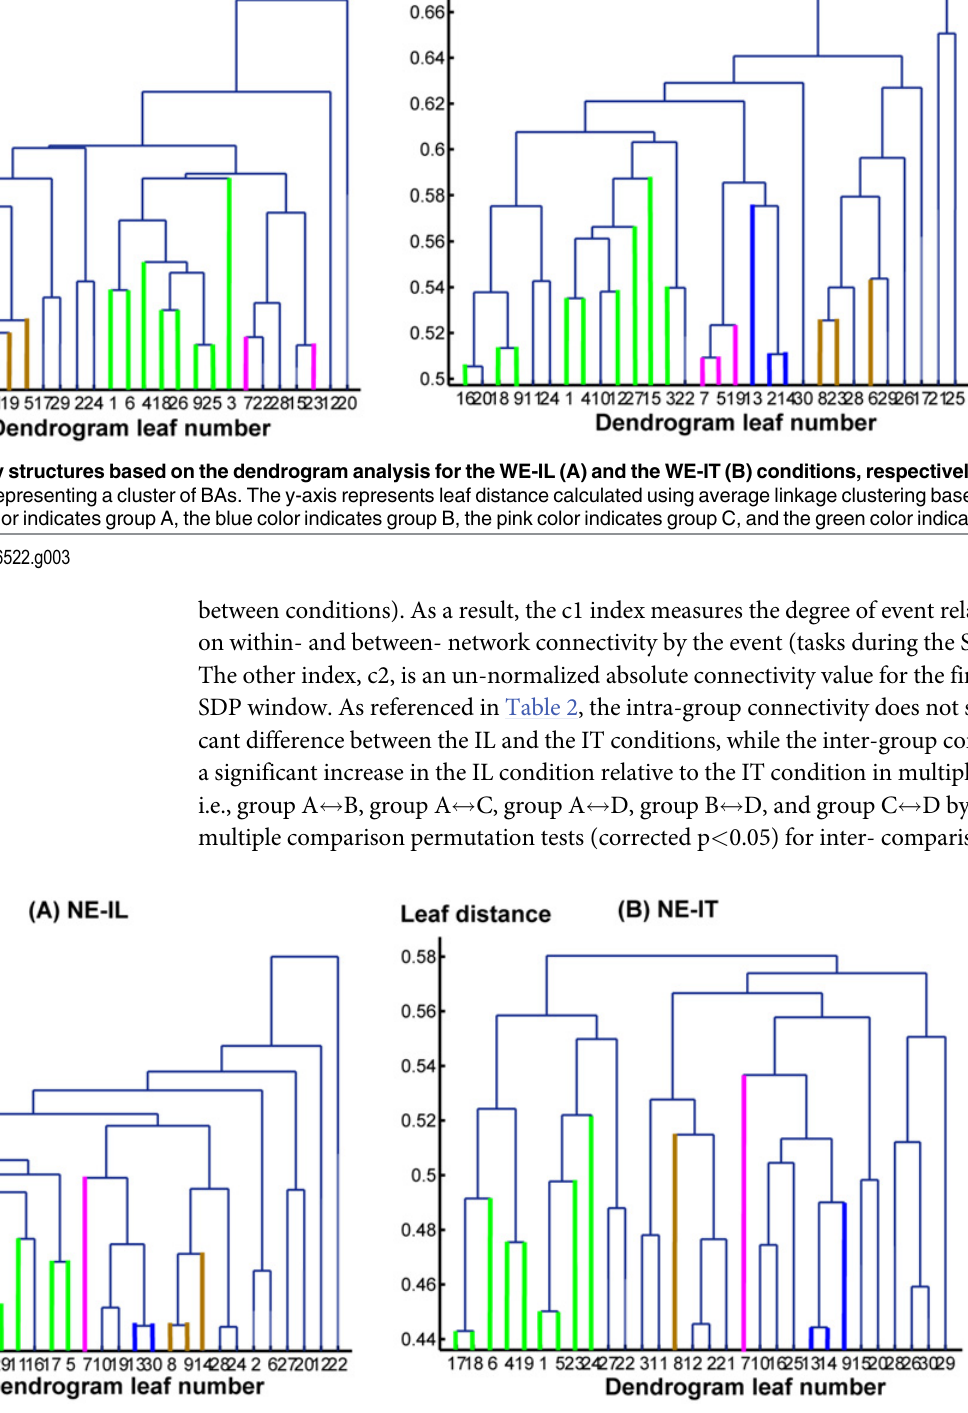
PLOS ONE | DOI:10.1371/journal.pone.0116522 February 13,